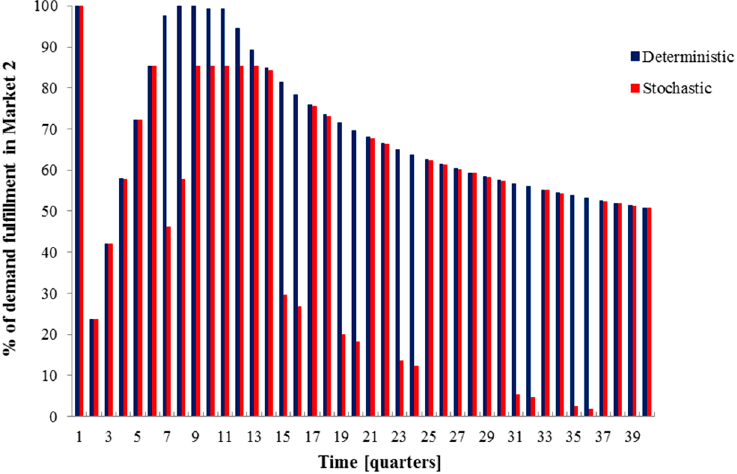
Figure 16. Variation of % of demand fulfilment in Market 2 for both deterministic (base case) and stochastic cases during the planning horizon.